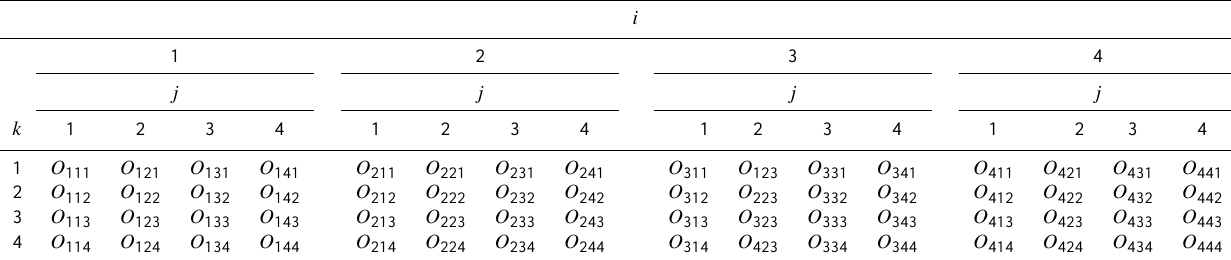
Table 4. Three-dimensional contingency table of observed drought class transitions O ijk .